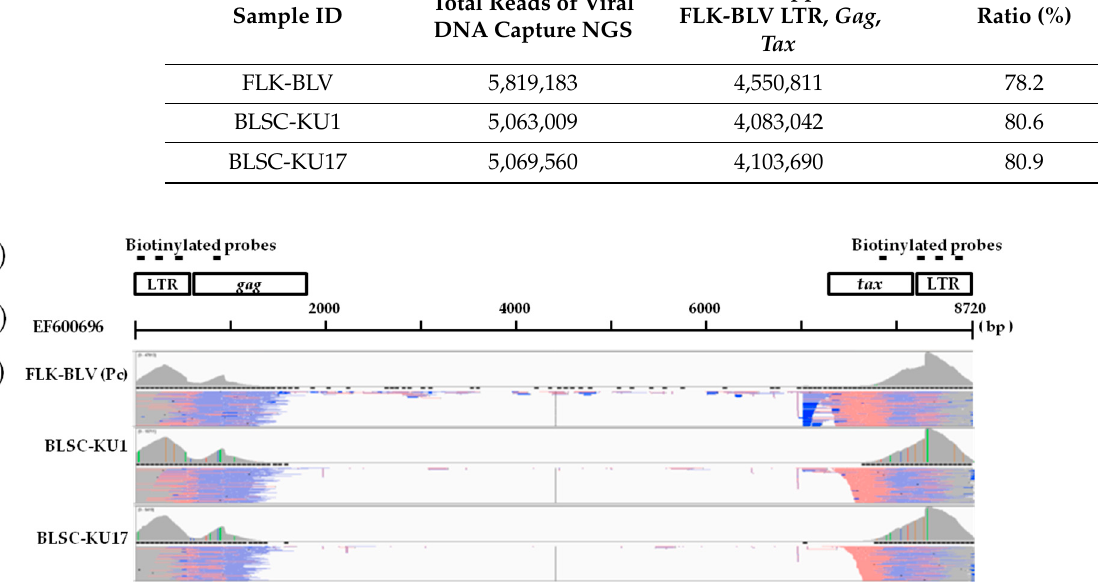
Table 1. Result of viral DNA capture target enrichment high-throughput NGS sequencing system.